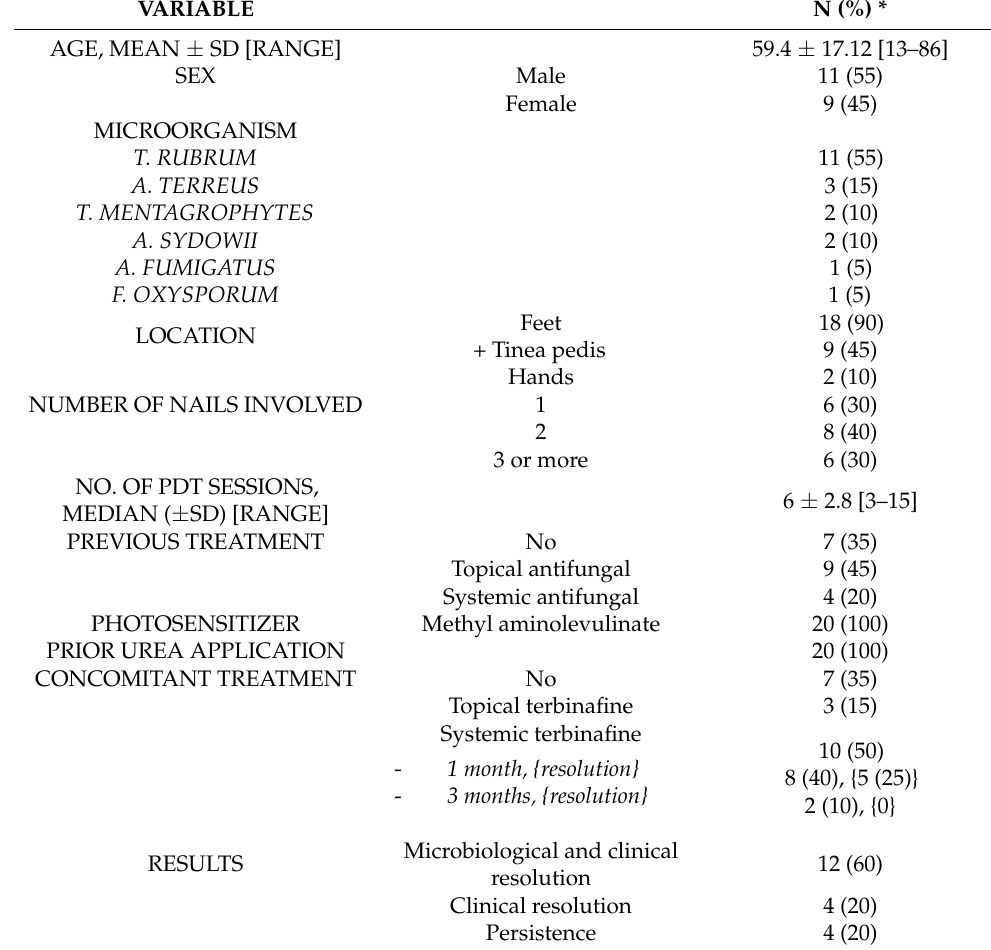
Table 1. Characteristics of the study